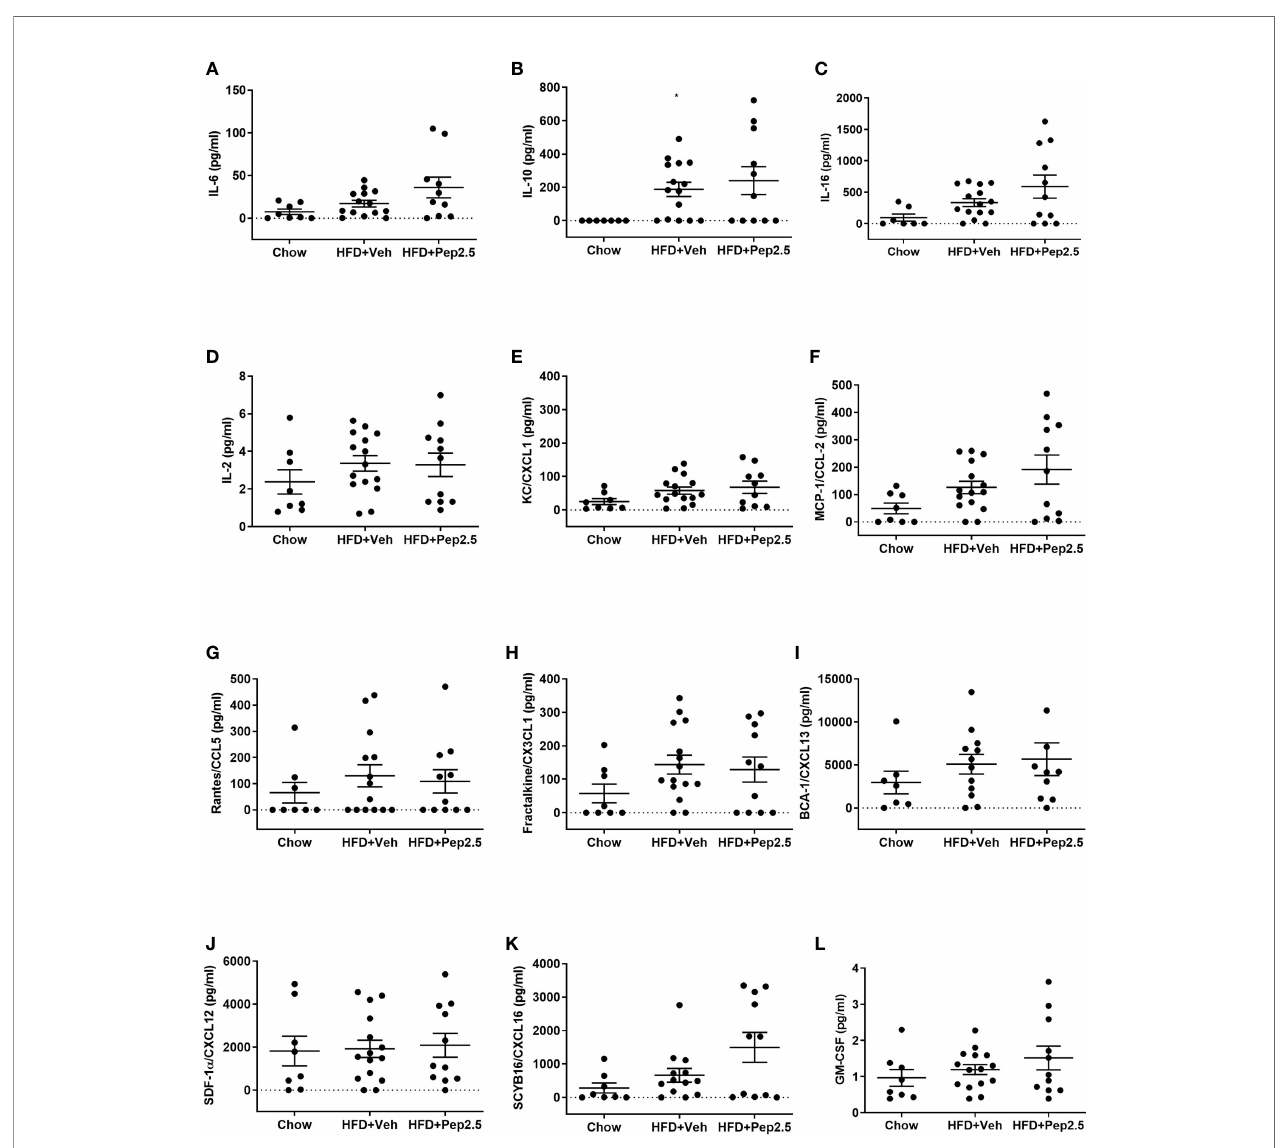
FIGURE 8 | Effect of peptide 19-2.5 on cytokine, chemokine and growth factor analysis in HFD-fed mice. Bio-plex pro mouse chemokine assay was performed on serum samples of mice collected at the end of the experiment. To measure the following chemokines, cytokines and growth factor: (A) IL-6 (pg/ml), (B) IL-10 (pg/ml), (C) IL-16 (pg/ml), (D) IL-2 (pg/ml), (E) KC/CXCL1 (pg/ml), (F) MCP-1/CCL2 (pg/ml), (G) Rantes/CCL5 (pg/ml), (H) Fractalkine/CX3CL1 (pg/ml), (I) BCA-1/ CXCL13 (pg/ml), (J) SDF-1 a /CXCL12 (pg/ml), (K) SCYB16/CXCL16 (pg/ml) and (L) GM-CSF (pg/ml). Data were analyzed by one-way ANOVA, followed by Kruskal-Wallis test, Dunn ’ s multiple comparison test. Data are expressed as mean ± SEM; chow (n=8), HFD+Veh (n = 15), HFD+Pep2.5 (n = 11) per group. *P < 0.05 vs.